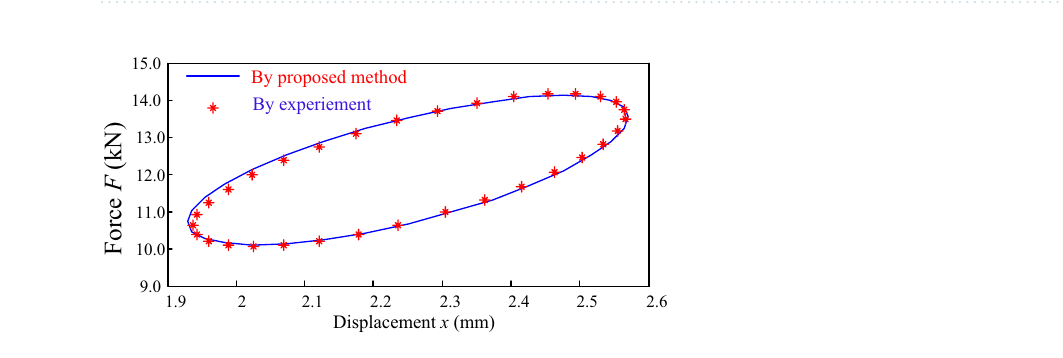
Figure 11. The nonlinear damping properties with respect to vibration amplitude and frequency.